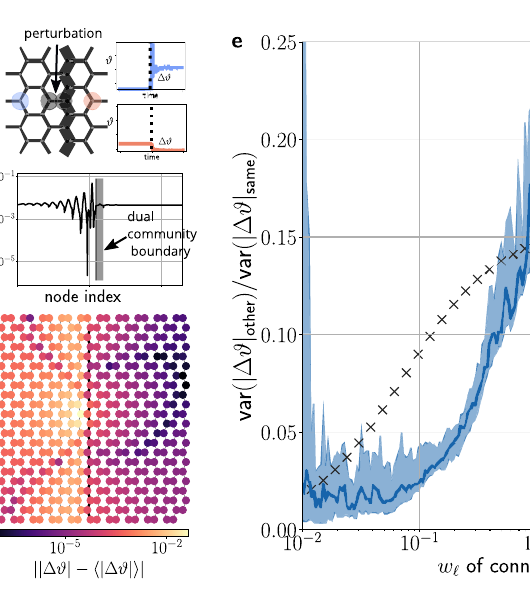
response within a network community (Eq. (21)). The response in the non- perturbed community is strongly suppressed — the more pronounced the commu- nity structure, the stronger the attenuation. The existence of a primal or dual communitystructureisindicatedbyprimalanddualFiedlervalues λ 2 (crosses)and λ * 2 (circles),respectively.The blueline representsthemedianvalueand theshaded regions indicate the 25 and 75% quantiles for different random realizations of the natural frequencies ω i . The symbol c denotes a normalization constant used to improve comparison with the